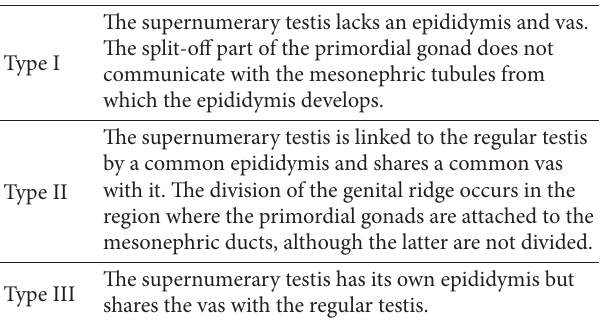
Table 1: Functional classification of polyorchidism based on embry- onic development (table derived from Thum